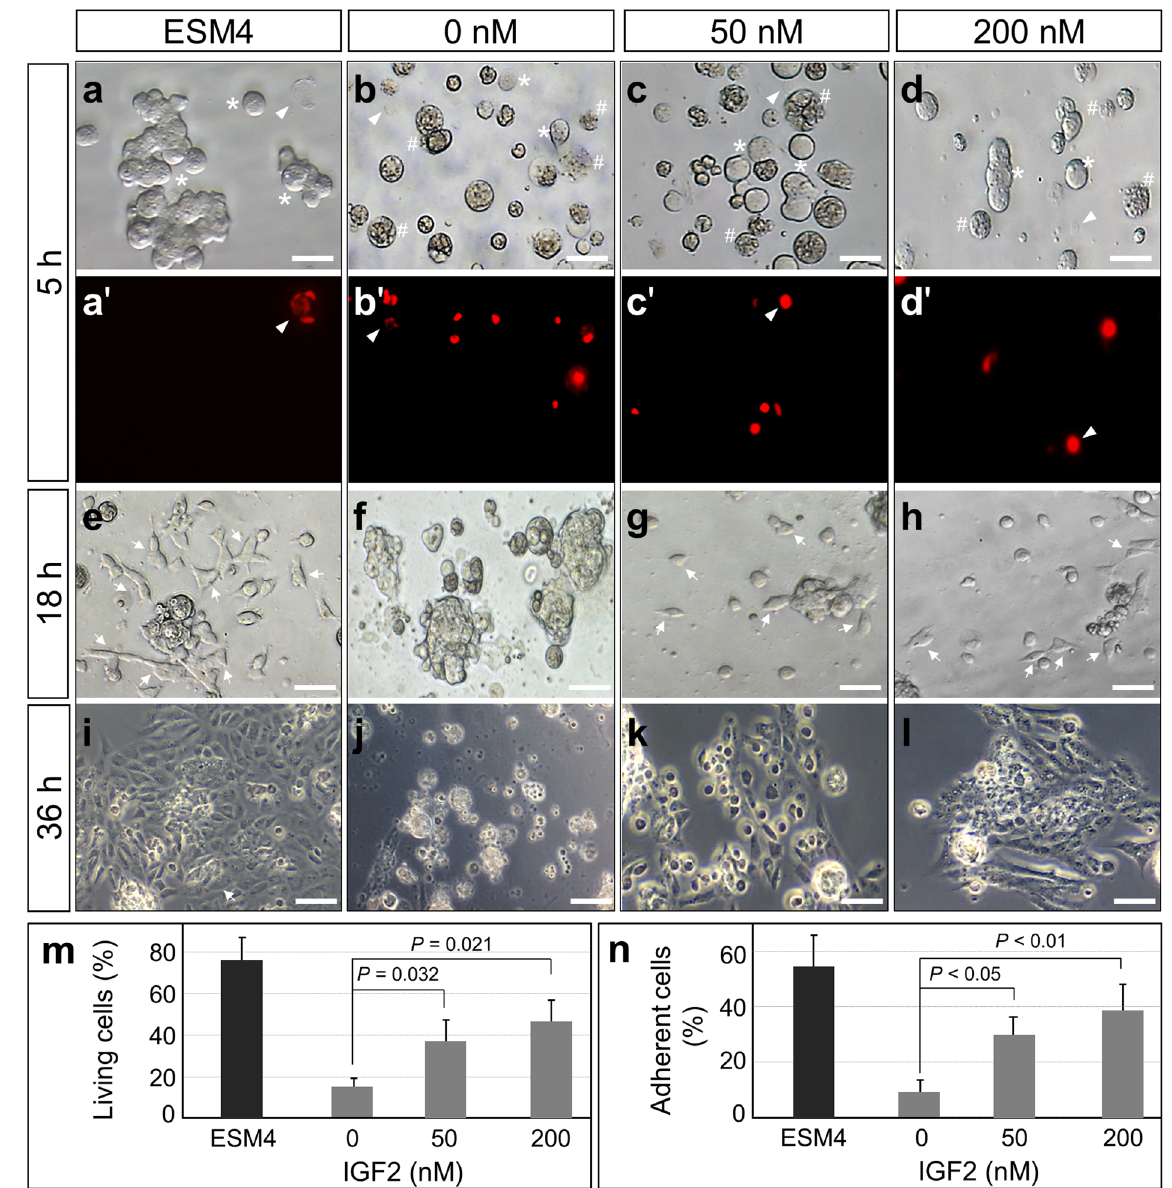
Figure 7. IGF2 supports the derivation of blastomeres in short-term culture. ( a–d ′ ) Micrographs and PI staining of madaka blastomeres cultured for 5 h. The madaka blastomeres were cultured in ESM4 or defined medium containing IGF2 at indicated concentration. The morphology of cells was recorded with phase contrast microscopy ( a–d ) to identify the living cells (asterisk) and necrotic/dead cells (hash). The dead cells and ghost cells (arrow head) were identified with PI staining ( a ′ –d ′ ). ( e–h ) Phase contrast micrographs of blastomeres cultured for 18 h, showing the attached cells (arrow) in primary culture. ( i–l ) Blastomeres cultured for 36 h, showing the derivation of cells. ( m ) Survival rate of blastomeres cultured for 5 h in medium containing IGF2 at indicated concentration. ( n ) Percentage of adherent cells in primary culture at 18 h, showing IGF2 promotes the cell viability and attachment. Scale bars, 20 μ